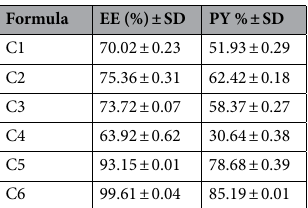
Table 3. Results of CLN-free base microsponge EE% and PY%.